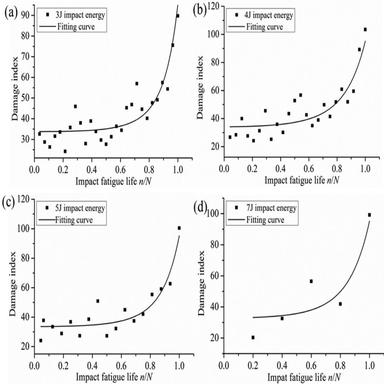
Parameter DI based on experimental measurement and fitting curve, the impact energies are : (a) 3 J, (b) 4 J, (c) 5 J and (d) 7 J.